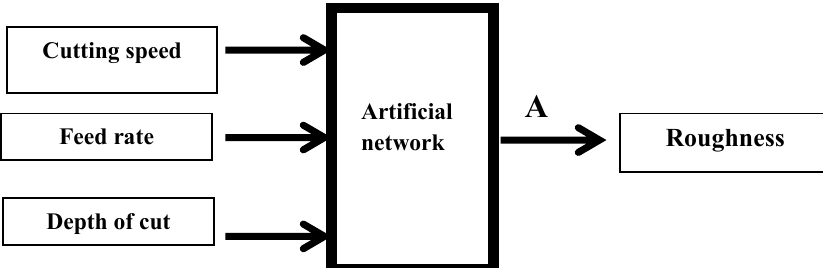
Fig. 3. Neural network schematic diagram for